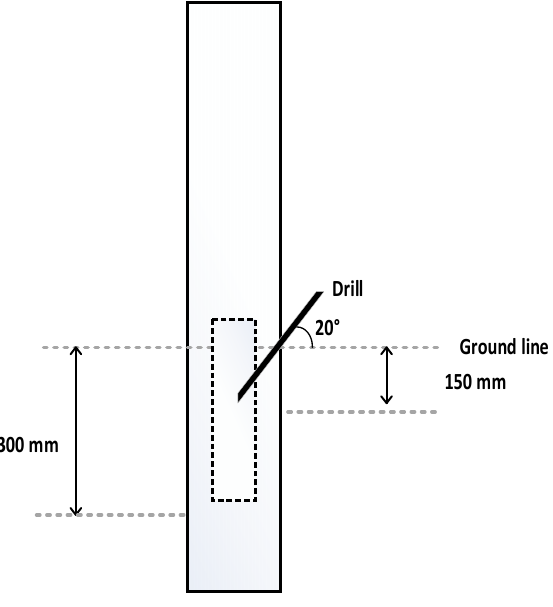
Figure 7. Pole inspection below ground line using dig and drill